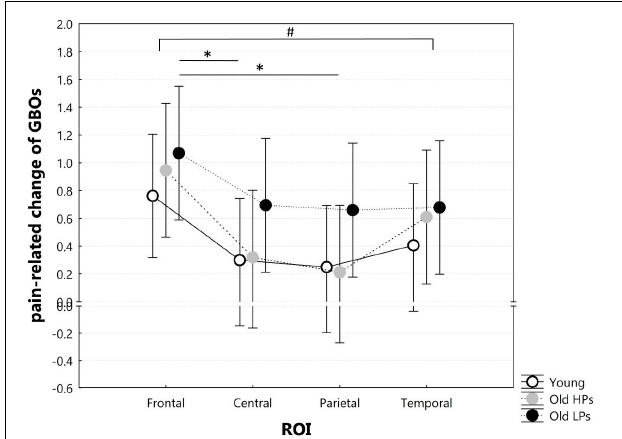
FIGURE 5 | Two-way ANOVA of group × ROI on pain-related change of GBOs. ROI defined as frontal (AF3, AF4, Fz), central (CP1, CP2, Cz), parietal (P3, P4, Pz), temporal (T7, T8, CP5, CP6). # Significant ROI effect on pain-related change of GBOs. *Significant difference for post hoc tests after Bonferroni correction for multiple